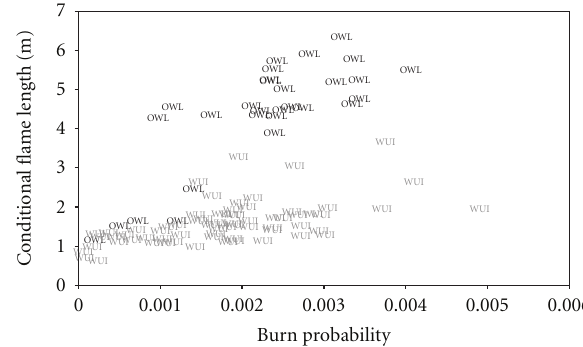
Figure 8: Scatter plot of burn probability versus conditional flame length estimated with FlamMap simulations for wildland urban interface (WUI) and northern spotted owl nesting sites on the 0.6 million ha Deschutes National Forest in central Oregon. Data points are average values for polygons (ca. 100–3,000 ha). The figure shows relative risk in terms of likelihood (burn probability) and potential intensity (average flame length) for the individual WUIs and nest sites.